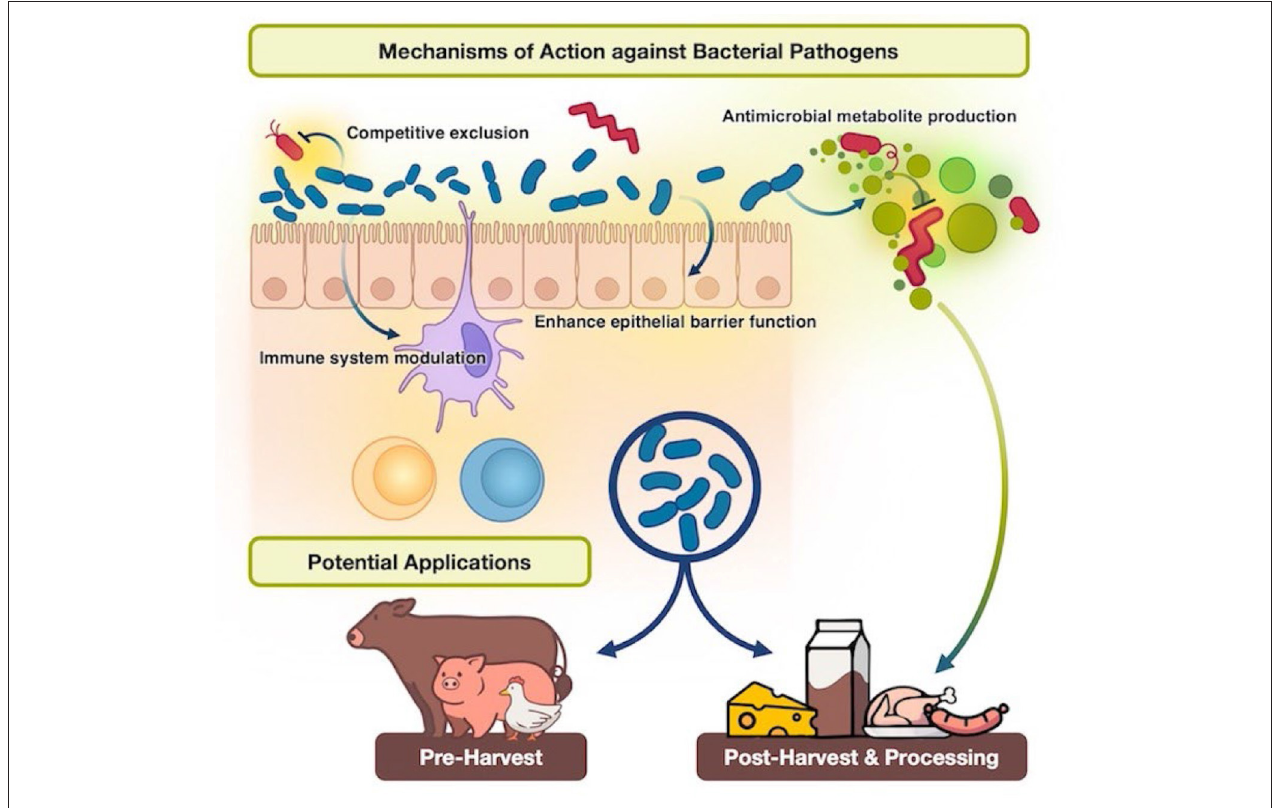
FIGURE 1 | The mechanisms behind the antimicrobial activity of lactobacilli against bacterial